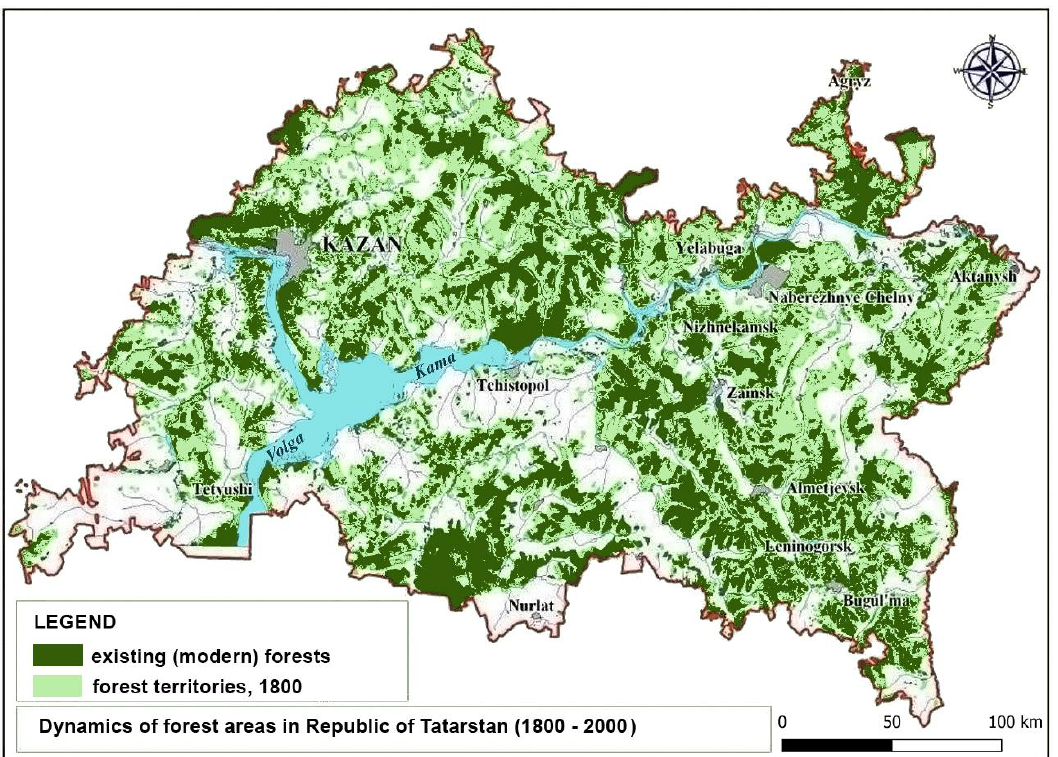
Figure 3. Dynamics of forest areas in the Republic of Tatarstan (1800–2000).